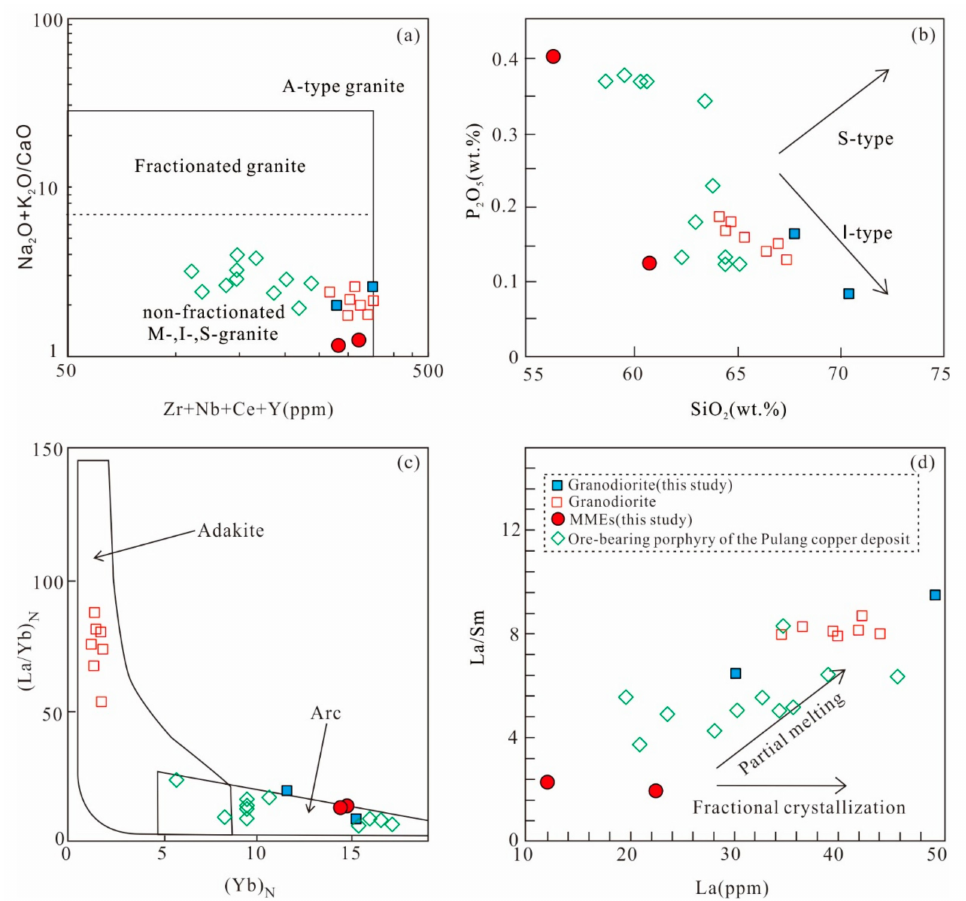
Figure 9. The chemical diagrams for granodiorite and MMEs. ( a ) (Na 2 O + K 2 O) / CaO vs. (Zr + Nb + Ce + Y) diagram [45]; ( b ) SiO / Yb) 2 vs. P 2 O 5 (after [46]); ( c ) Yb N vs. (La N (after [57]) and ( d ) La